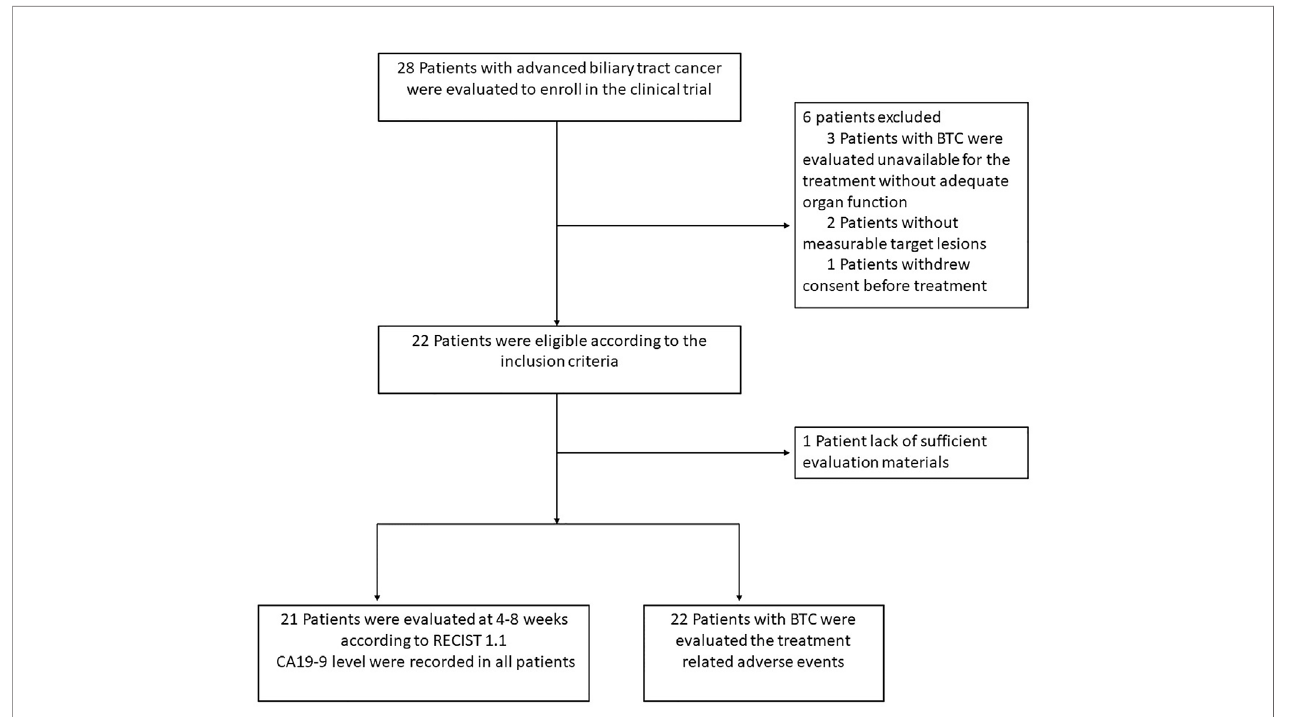
FIGURE 1 | Flow diagram of study